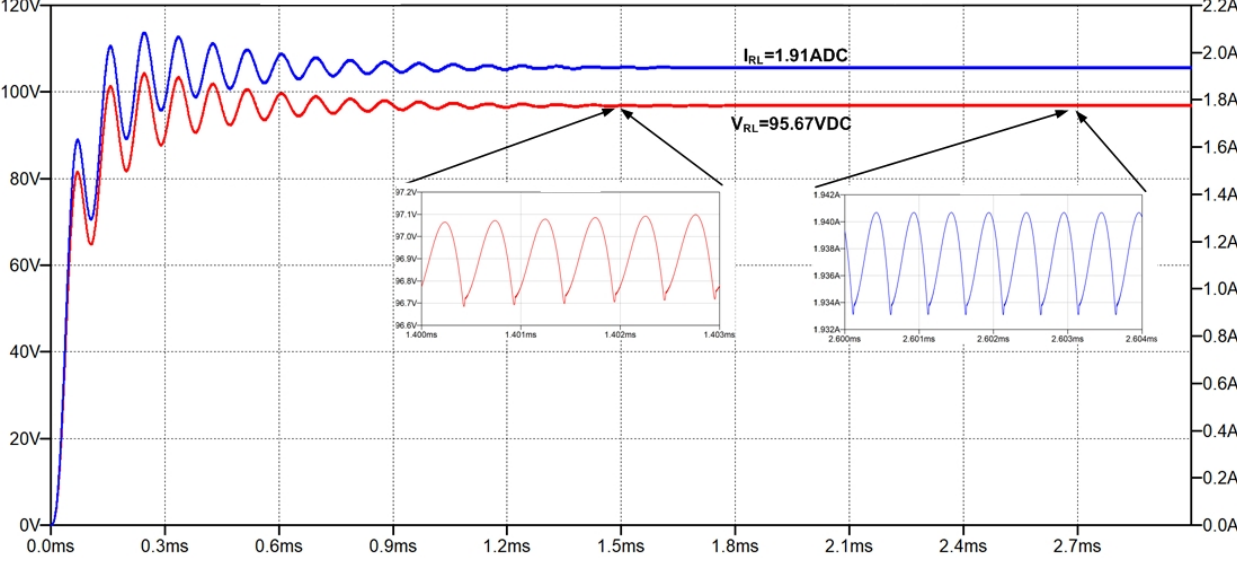
Figure 19. Voltage V RL =95.67VDC(red) and current I RL =1.91ADC (blue) waveforms at the load.